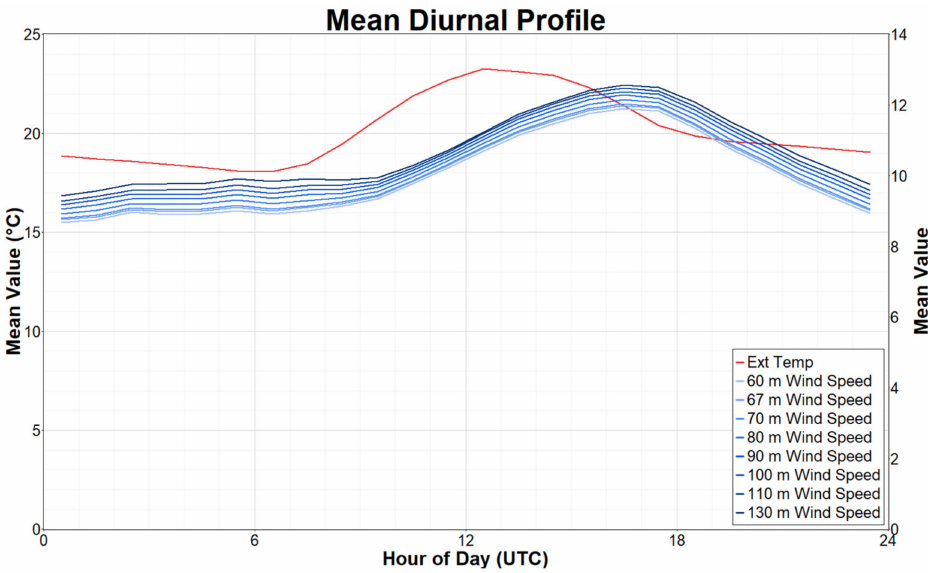
Figure 6. Mean diurnal profile of wind speed at multiple levels and temperatures.